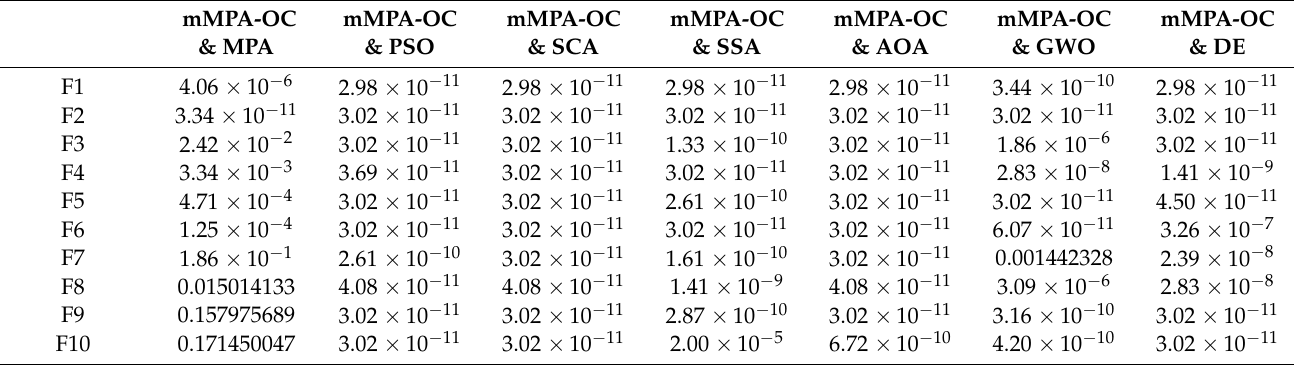
Table 17. p -values of the Wilson rank-sum test of mMPA-OC and the comparison algorithm in CEC-2019.